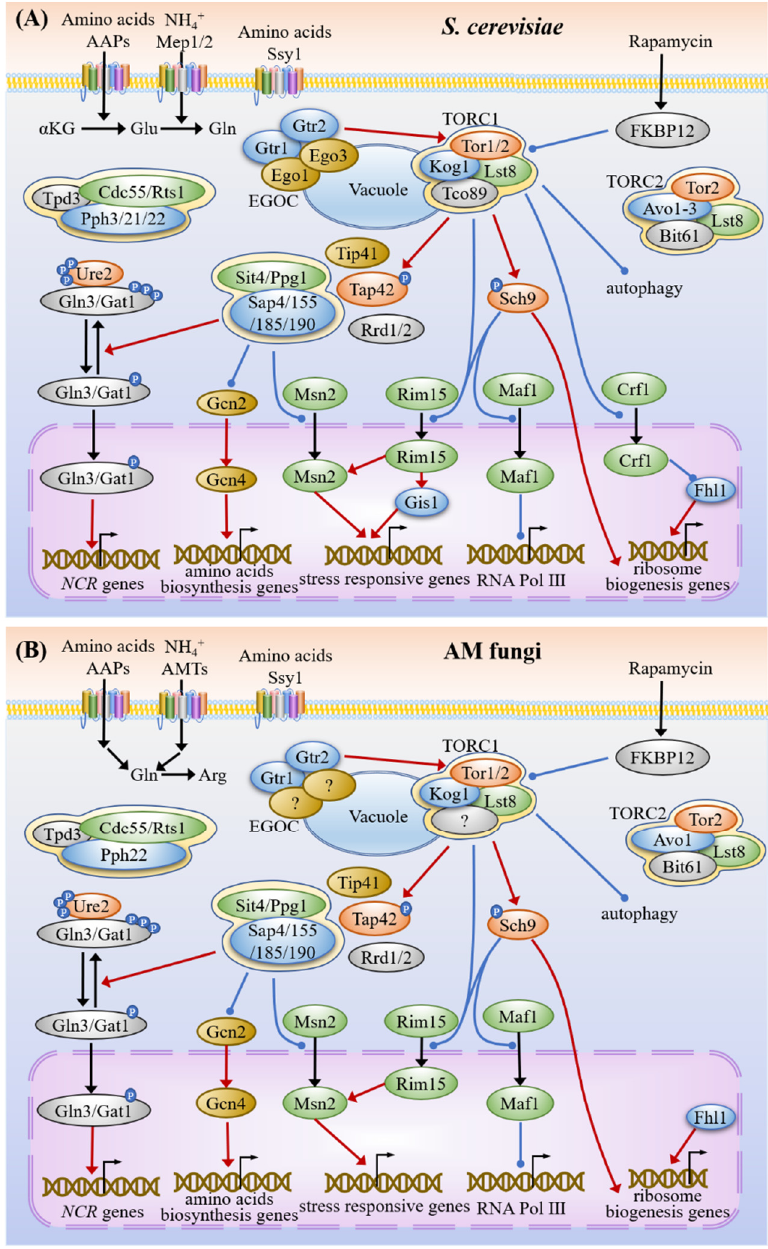
Figure 4. TOR signaling pathways in yeast ( A ) and AM fungi ( B ). The amino acids are sensed by Ssy1 and transported by the amino acid permeases (AAPs), while the ammonium is sensed and transported by AMTs/Meps. The increase in amino acids levels also activates TORC1 via the EGO complex, which is composed of Gtr1, Gtr2 and other unknown proteins. TORC1 is localized to the vacuolar membrane, consisting of Tor2, Kog1 and Lst8. The activated TORC1 phosphorylates the downstream targets Sch9 and Tap42. Tap42 associates with phosphatase PP2A (Pph22, Tpd3 and Cdc55/Rts1) and PP2A-related protein phosphatases (Sit4/Ppg1 and Sap190) complexes, along with the regulatory protein Rrd1/2. TORC1 enhances the hyperphosphorylation and association of Gln3/Gat1 and Ure2, preventing the nuclear localization of Gln3/Gat1 via the Tap42-PP2A complex, resulting in the suppression of genes related to nitrogen catabolite repression (NCR) and use of less preferred nitrogen sources. Tip41 interacts with Tap42 to negatively regulate the TOR pathway. Rapamycin binds to its receptor FKBP12 encoded by FPR1 to form a complex, which can bind Tor2, thereby inhibiting TORC1. TORC1 promotes Sch9 activity that can phosphorylate Maf1 to activate RNA polymerase III-transcribed genes. Tap42 effector positively regulated by TORC1 prevents the translation of Gcn4, a transcriptional activator needed for amino acid biosynthesis. Tor2 also can bind to Avo1, Sit4 and Bit61 to form the TORC2 complex. The proteins Tco89, Ego1 and Ego3 are